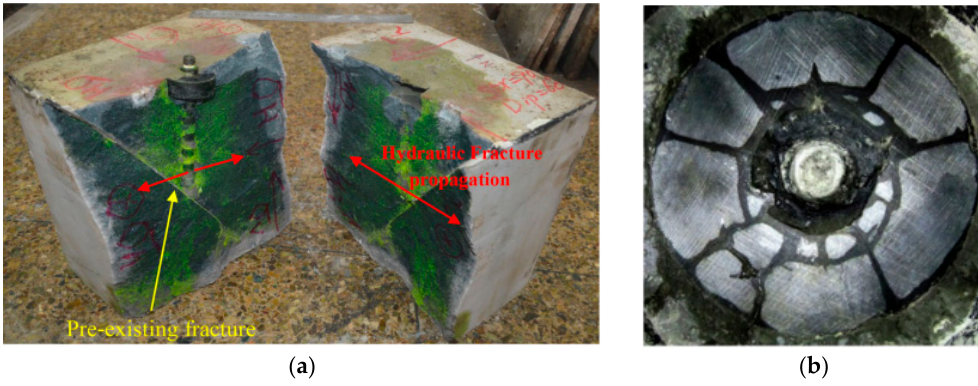
Figure 6. Crack pattern comparison ( a ) a single crack in hydraulic fracturing [68]; ( b ) multiple radial fractures with SCDA [69].